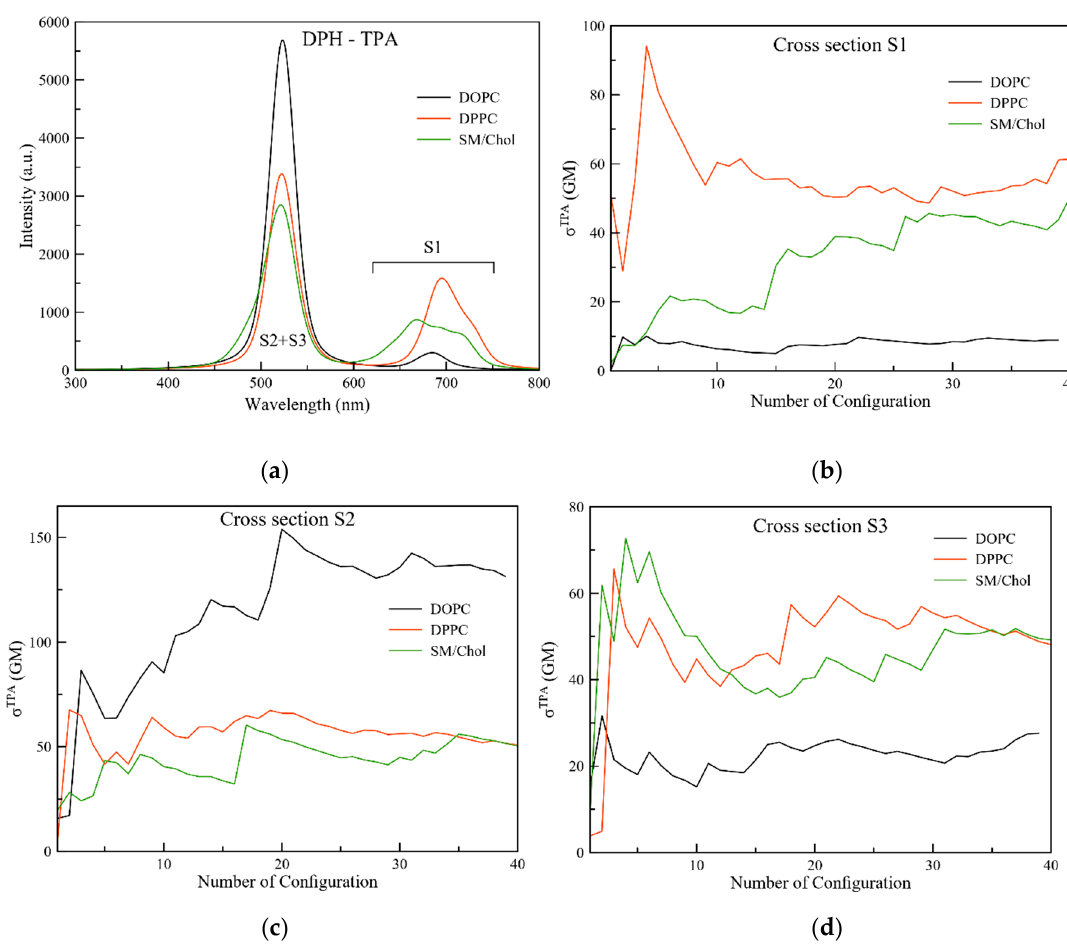
Figure 3. ( a ) Two photon absorption spectra of DPH in the three different membranes; ( b-d ) Cross section of the low-lying excited states of DPH in the different environments.